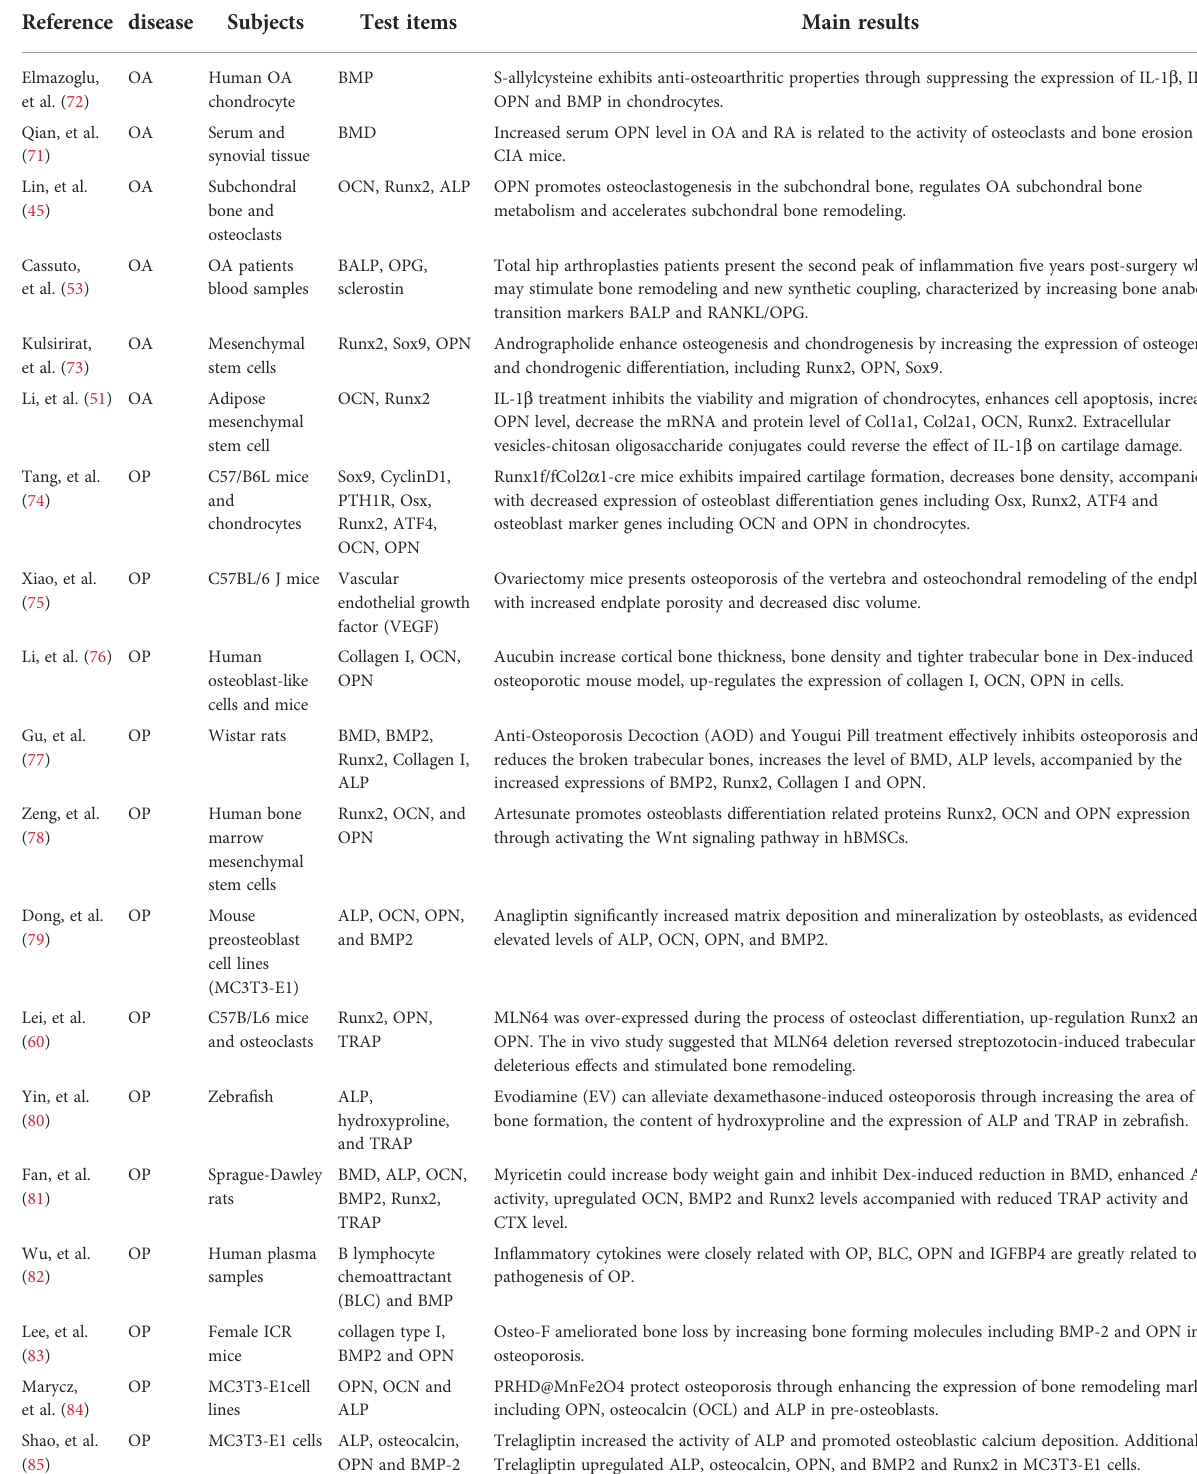
TABLE 2 OPN involves bone metabolism in OA and